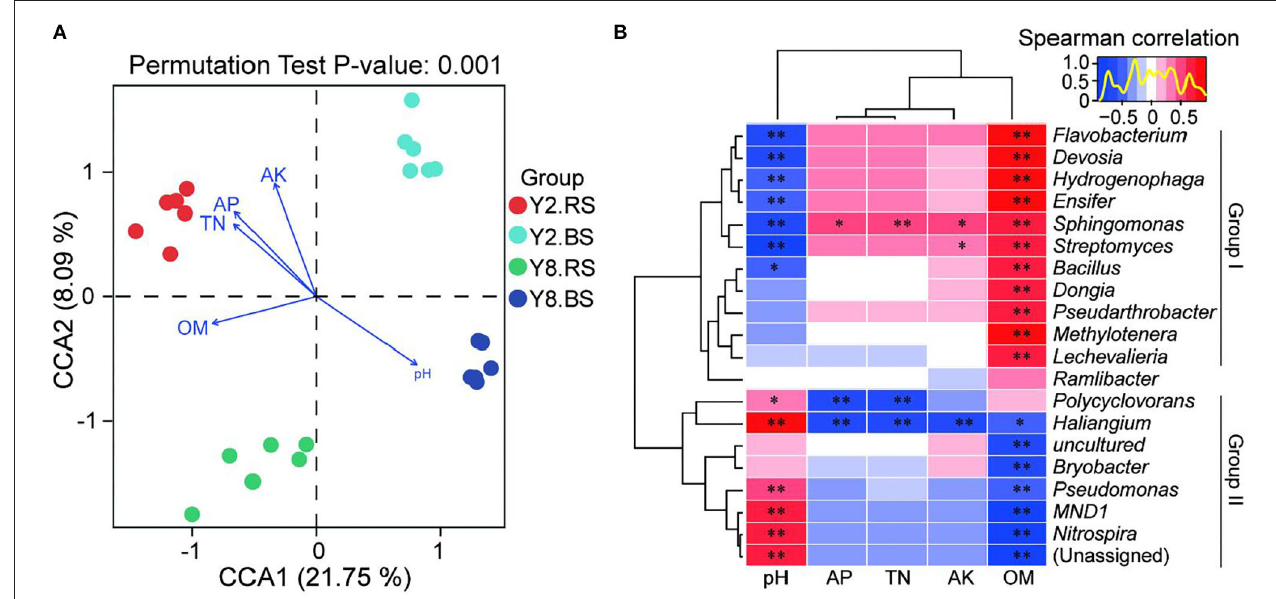
FIGURE 6 | Correlation analysis between soil microbiome compositions and soil environmental variables. (A) Canonical correspondence analysis (CCA) based on the OTU level of soil bacteria and soil environmental variables. (B) Heatmap of Spearman’s correlation coefficients combined with a cluster analysis between the top 20 bacterial genus and physicochemical characteristics of rhizosphere soil and bulk soil. The red color represents a positive relationship, the blue color represents negative relationships, and the darker color indicates higher correlation. Y2.RS, rhizosphere soil of 2 years of continuous cropping; Y8.RS, rhizosphere soil of 8 years of continuous cropping; Y2.BS, bulk soil of 2 years continuous of cropping; Y8.BS, bulk soil of 8 years of continuous cropping. pH, soil pH; OM, organic matter; TN, total nitrogen; AP, soil available phosphors; AK, soil available potassium. p -value is correlation test result (* p < 0.05; ** p <